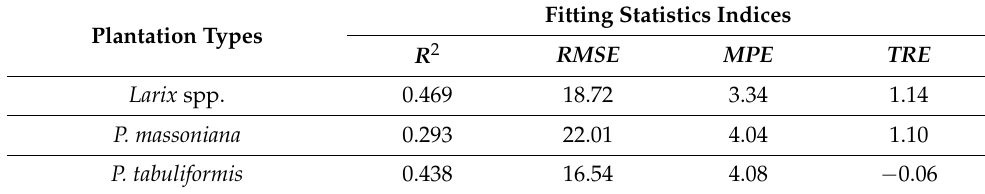
Table 4. Fitting statistics indices of Model